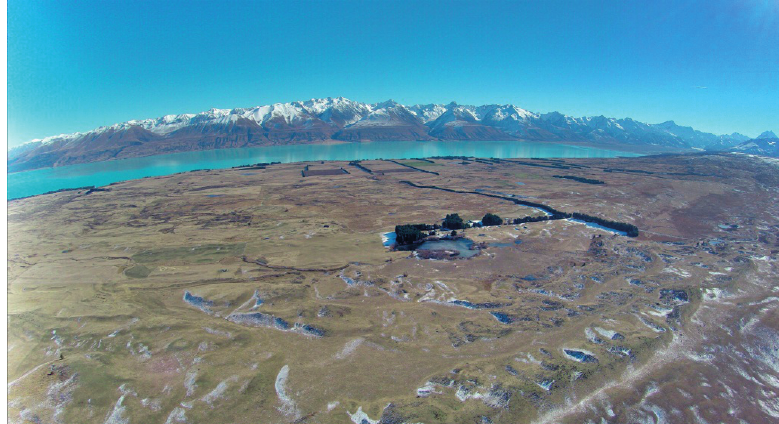
Figure 10. Aerial shot of the launch area for Milly.